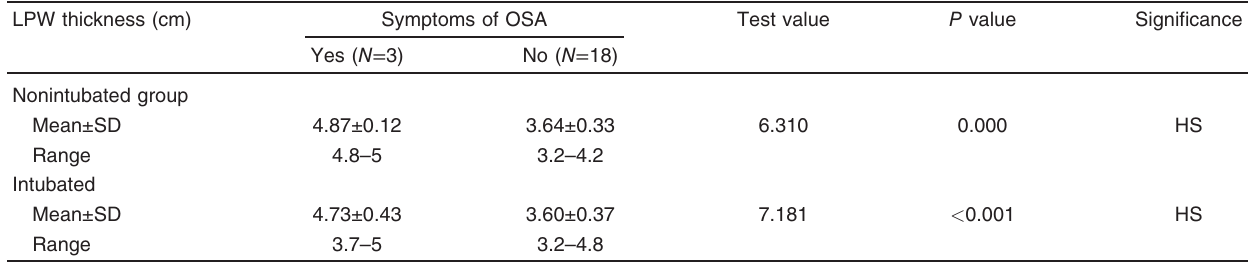
Table 5 Comparison between symptoms of obstructive sleep apnea in terms of lateral pharyngeal wall thickness LPW thickness (cm) Symptoms of OSA Test value